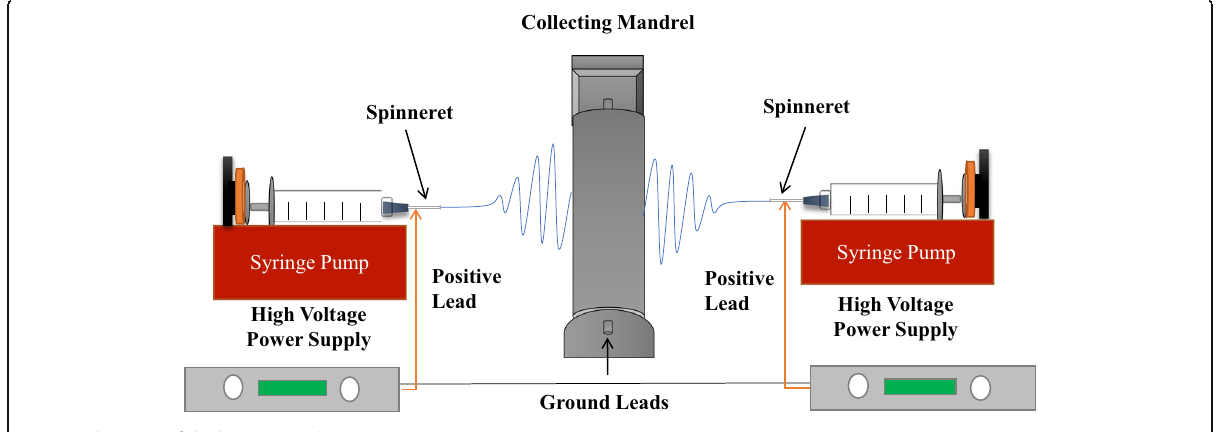
Fig. 1 Schematic of dual-spinneret